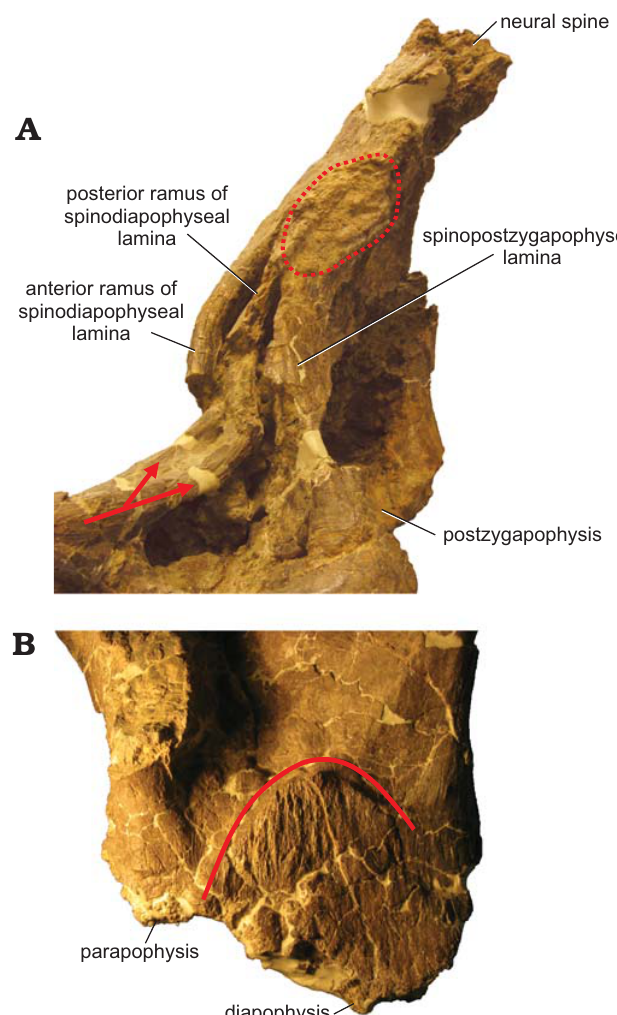
Fig. 6. Examples of osteological correlates of soft tissue attachment on dor- sal vertebrae of titanosaurian sauropod Dreadnoughtus schrani Lacovara, Lamanna, Ibiricu, Poole, Schroeter, Ullmann, Voegele, Boles, Carter, Fowler, Egerton, Moyer, Coughenour, Schein, Harris, Martínez, and Novas, 2014, from Santa Cruz Province, Argentina; middle–late Campanian to early Maastrichtian. A . Neural spine of MPM-PV 1156?-9 in left lateral view. Arrows mark the initial split of the a- and p-SPDL. Dotted line encir- cles the osteological correlate on the neural spine. B . Left transverse process of MPM-PV 1156?-8 in dorsal view. Solid line marks the semicircular mar- gin of the striations on the transverse process. Not to